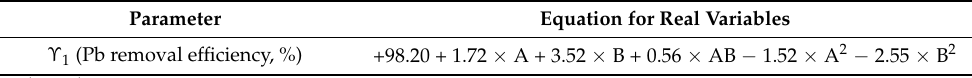
Table 3. The quadratic models for predicting responses of DO concentrate using the PA-ECF process. Parameter Equation for Real